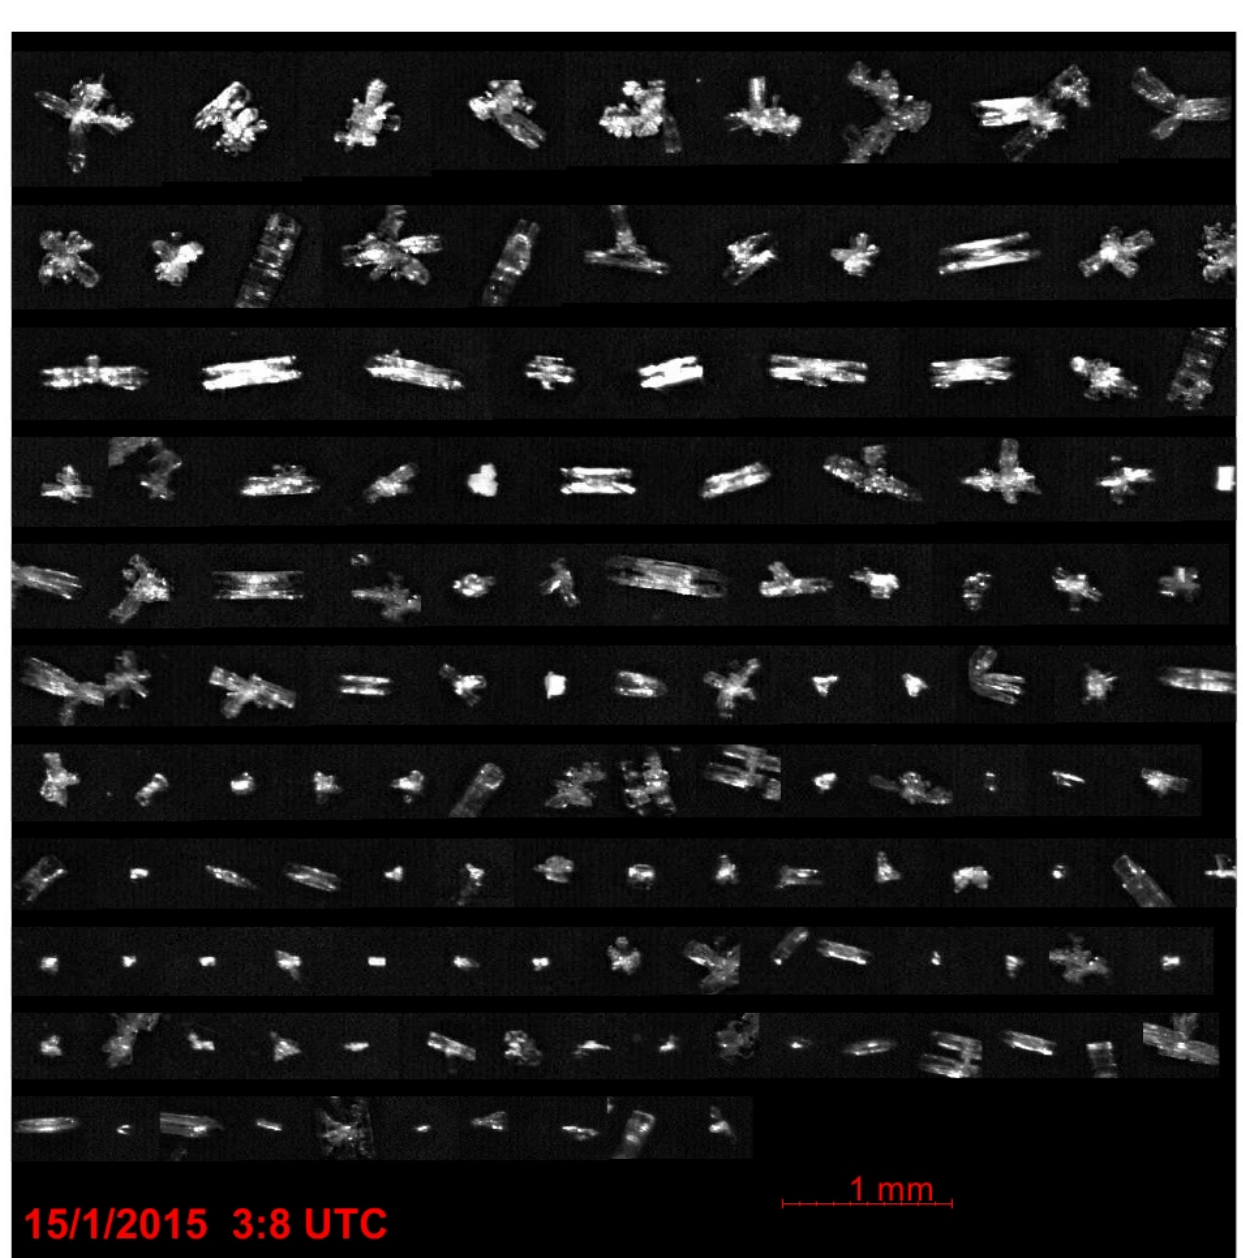
Figure 13. Example of a summary image for a single